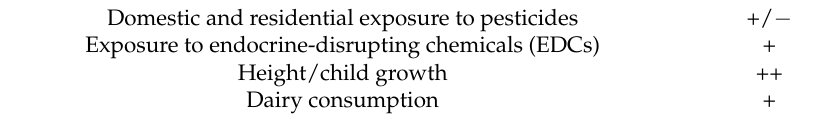
Table 1. Summary evaluation of associations between infancy/childhood risk factors and testicular cancer (TC) according to recently published epidemiological studies (2000–2015). Environmental Childhood Risk Factors That May Be Linked to Testicular Cancer Domestic and residential exposure to pesticides +/ − Exposure to endocrine-disrupting chemicals (EDCs) + Height/child growth ++ Dairy consumption + +, significant association; +/ − ,